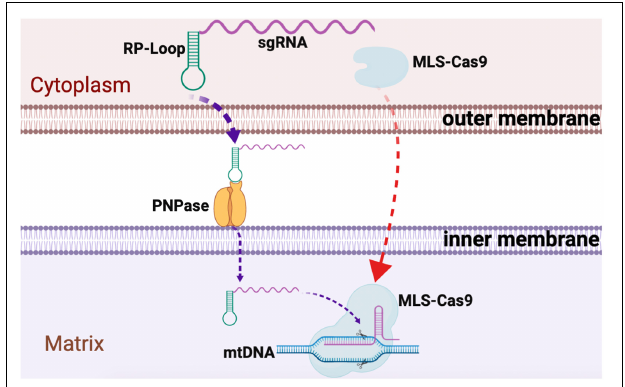
FIGURE 4 | Graphical summary of CRISPR/Cas9 delivery into the mitochondria. Guide RNA, with RP loop attached upon transfection, is imported into the mitochondria by attaching to PNPase in the inner mitochondrial membrane (IM). Cas9 protein with N-terminus mitochondria localization sequences (MLS) targets Cas9 to the mitochondria where it forms a complex with the RP loop sgRNA to cause sequence-specific mtDNA